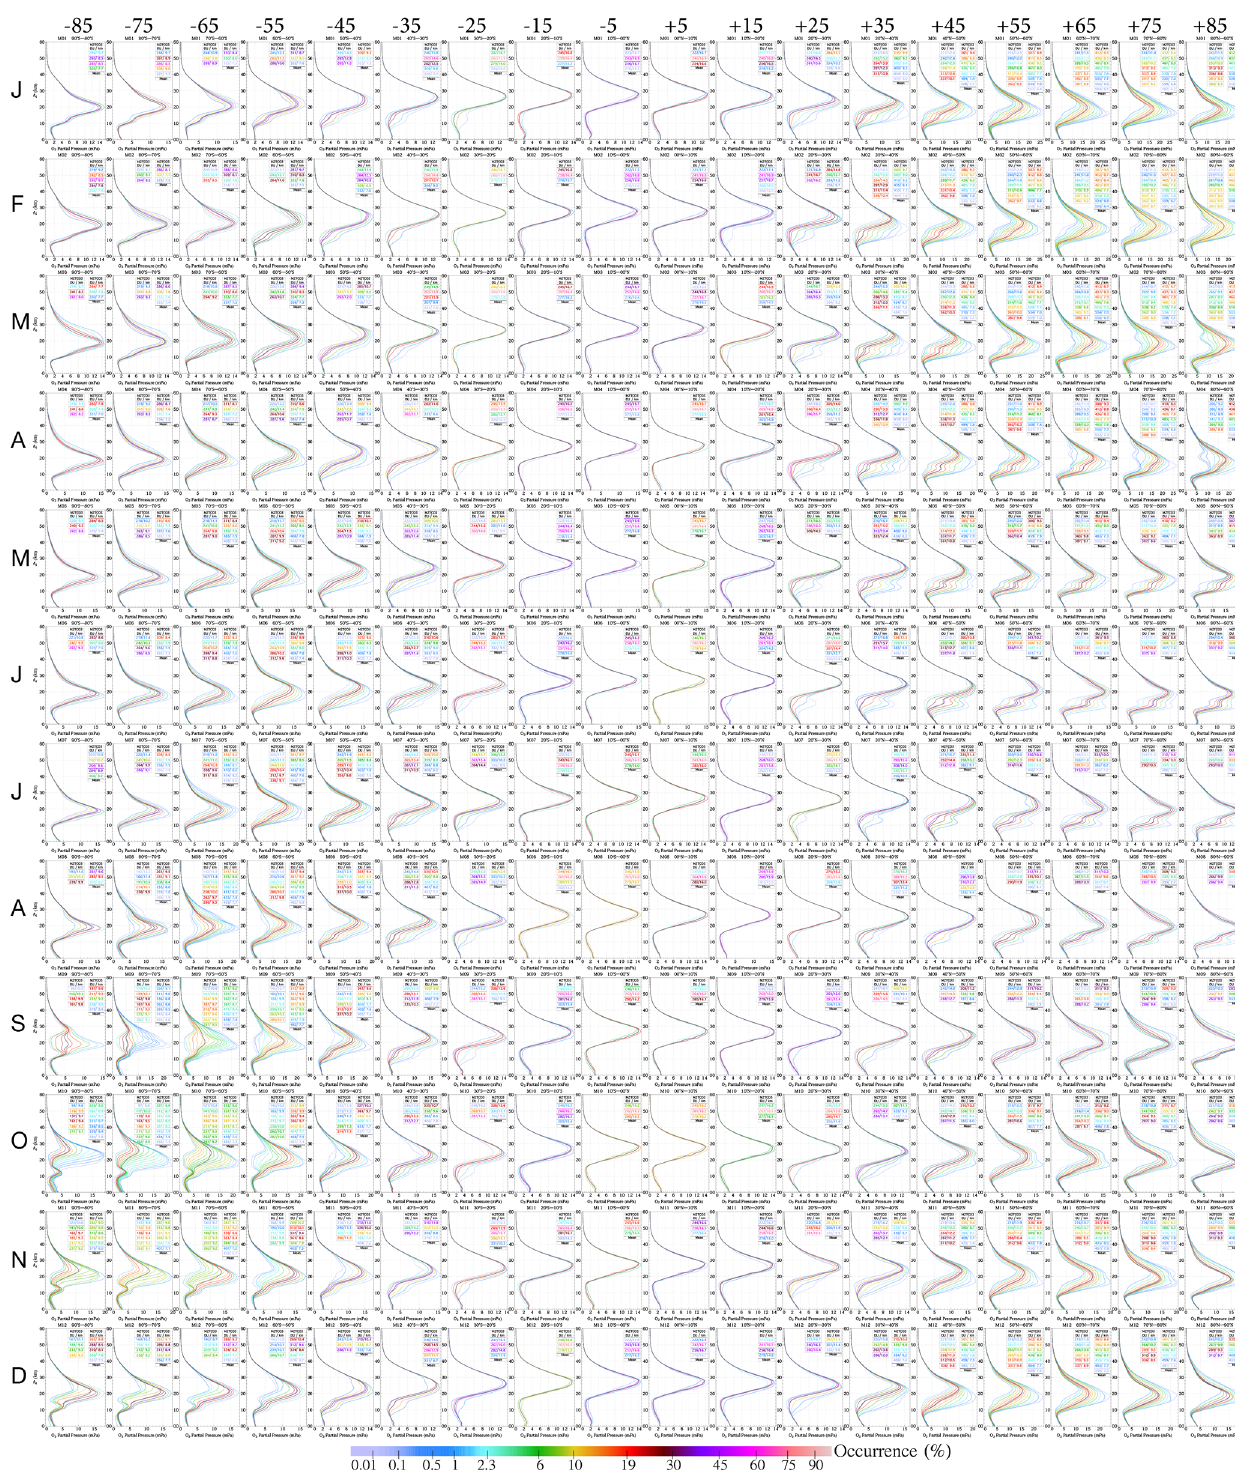
Figure A3. The daytime M2TCO3 climatology contains 1644 O 3 profiles that are distributed among the 12 × 18 month–latitude classes. The color of a solid line indicates the percentage occurrence of the profile. The line legends display the average tropopause altitudes and the average total O 3 columns. The solid gray line represents the downgraded M2TCO3 profile, i.e., the monthly zonal mean